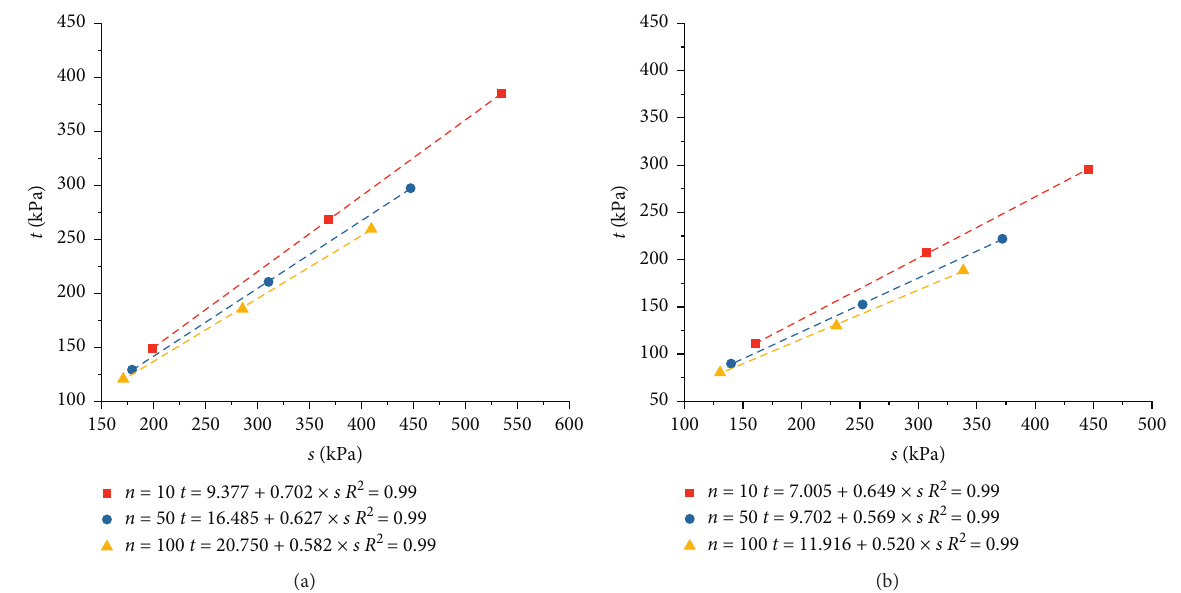
Figure 5: S-t diagrams for the test soils. (a) Before F-T cycles. (b) After F-T